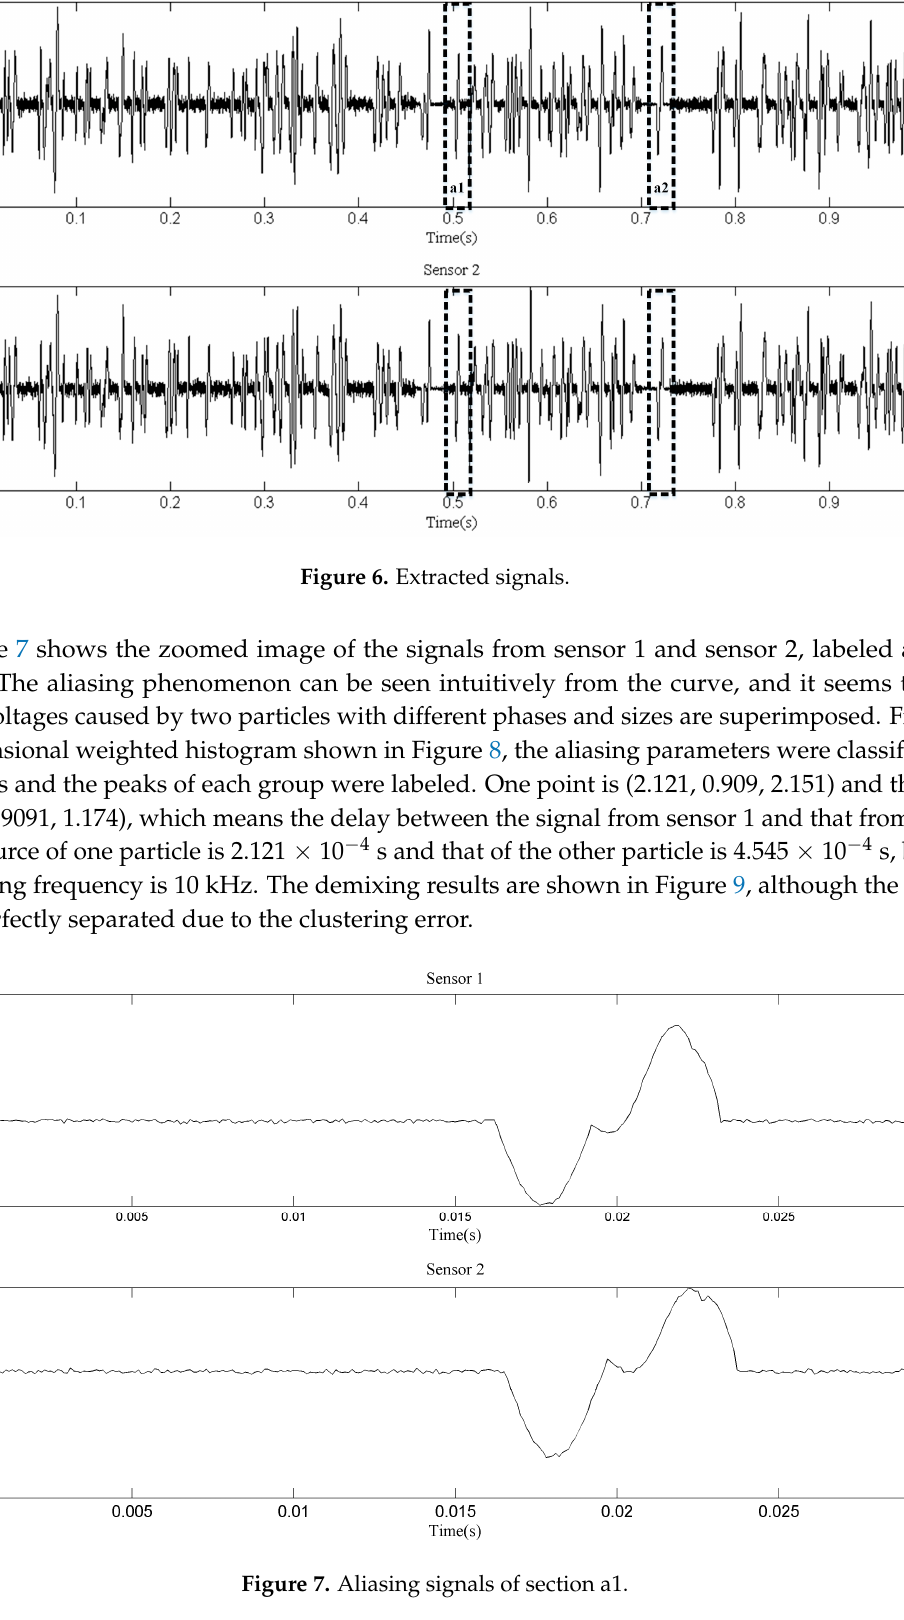
Figure 7. Aliasing signals of section a1.